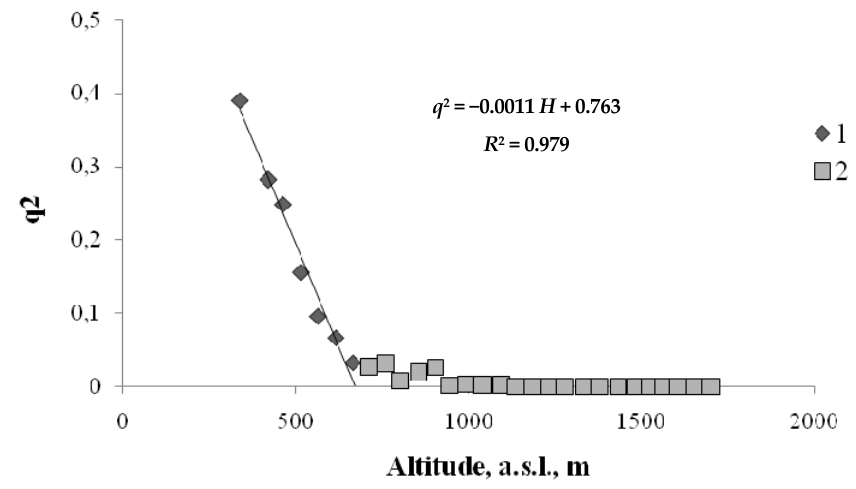
Figure 5. Order parameter versus height for the hardwood–conifer ecotone on the north-facing transect (1—ecotone; 2—coniferous belt).